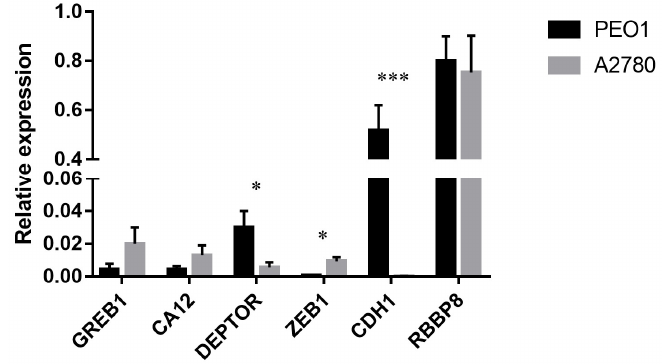
Figure 3. Relative expression level of GREB1 , CA12 , DEPTOR , ZEB1 , CDH1 and RBBP8 in the PEO1 and A2780 cell lines. Relative expression was determined using GAPDH as reference. Total RNA was isolated from the cell lysates of non-treated cells. Data are presented as mean ± S.D. Significance was determined between the ΔCT values of the PEO1 and A2780 cell lines: * p < 0.05; *** p < 0.001.